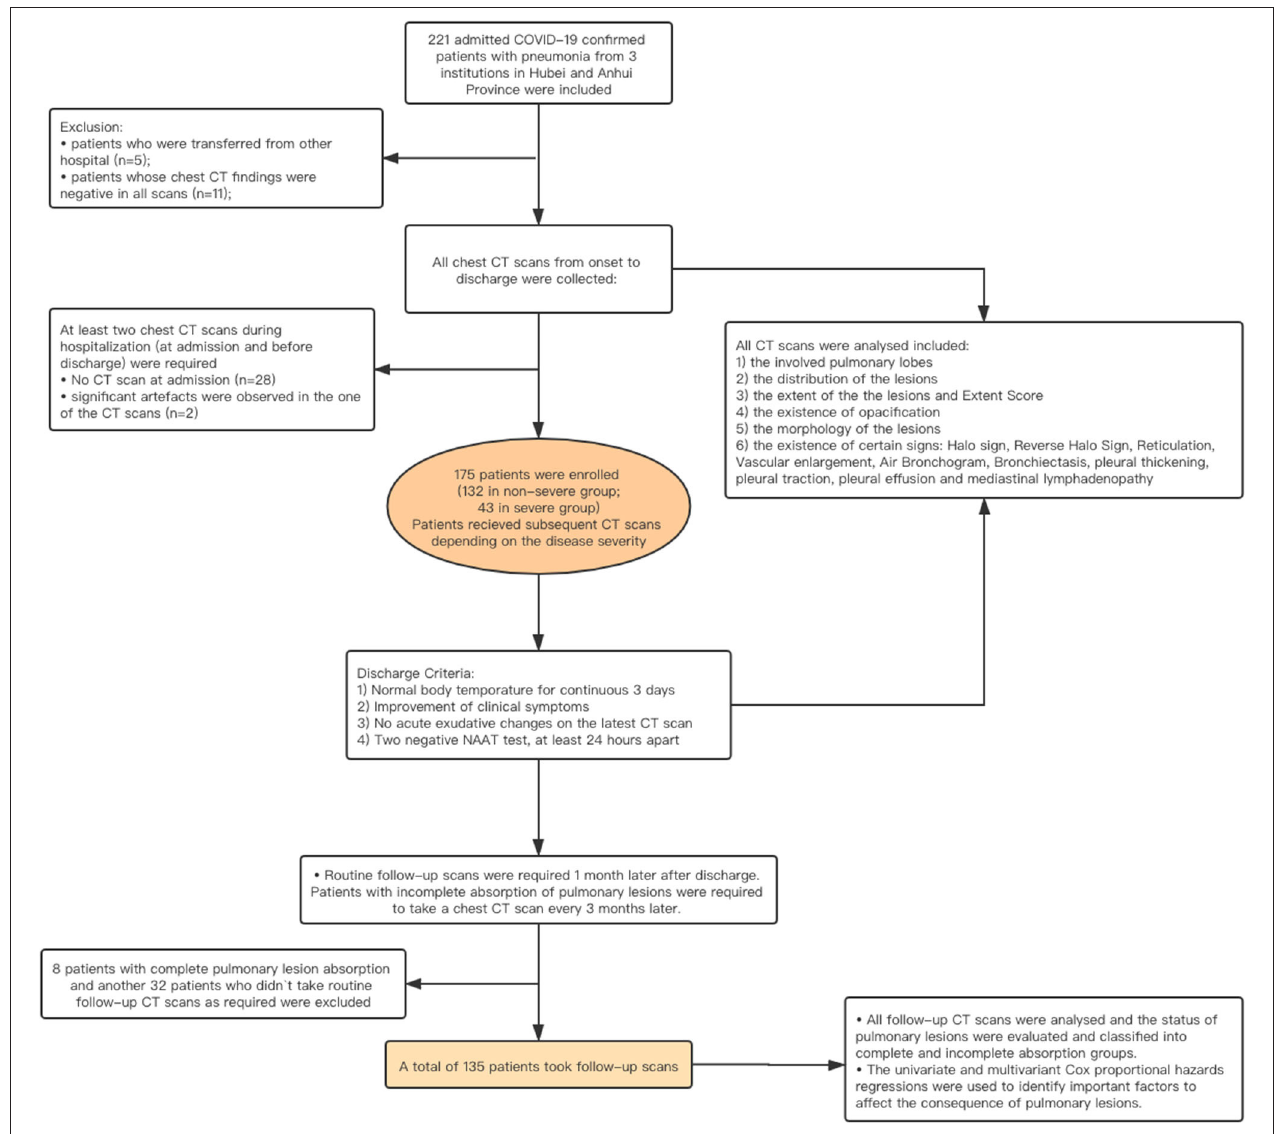
FIGURE 1 | Workflow of the study.